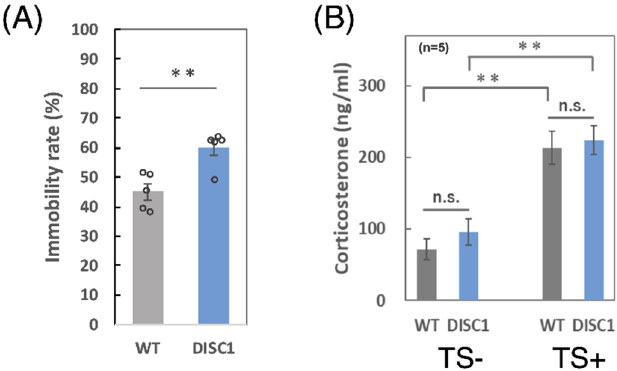
Figure 2. Comparison between WT and DISC1 mutant mice. ( A ) Immobility ratio. The immobility ratio of the mice ( n = 5, 8 weeks, male) was measured during a tail suspension test. Error bars indicate the SEM (**: p < 0.01). ( B ) Concentration of corticosterone. The concentration of corticosterone, which is a marker of stress exposure, in serum was analyzed in the four groups of mice. DISC1 indicates DISC1 mutant mice and TS indicates the tail suspension. The concentration of corticosterone was determined using ELISA. Error bars indicate the SEM (**: p < 0.01).